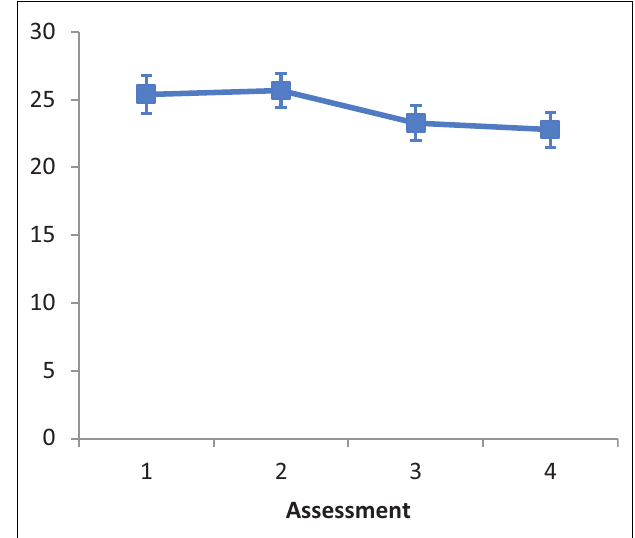
FIGURE 6 | LN patients’ performance on the CBS as a function of assessment . Error bars represent 1 SEM.